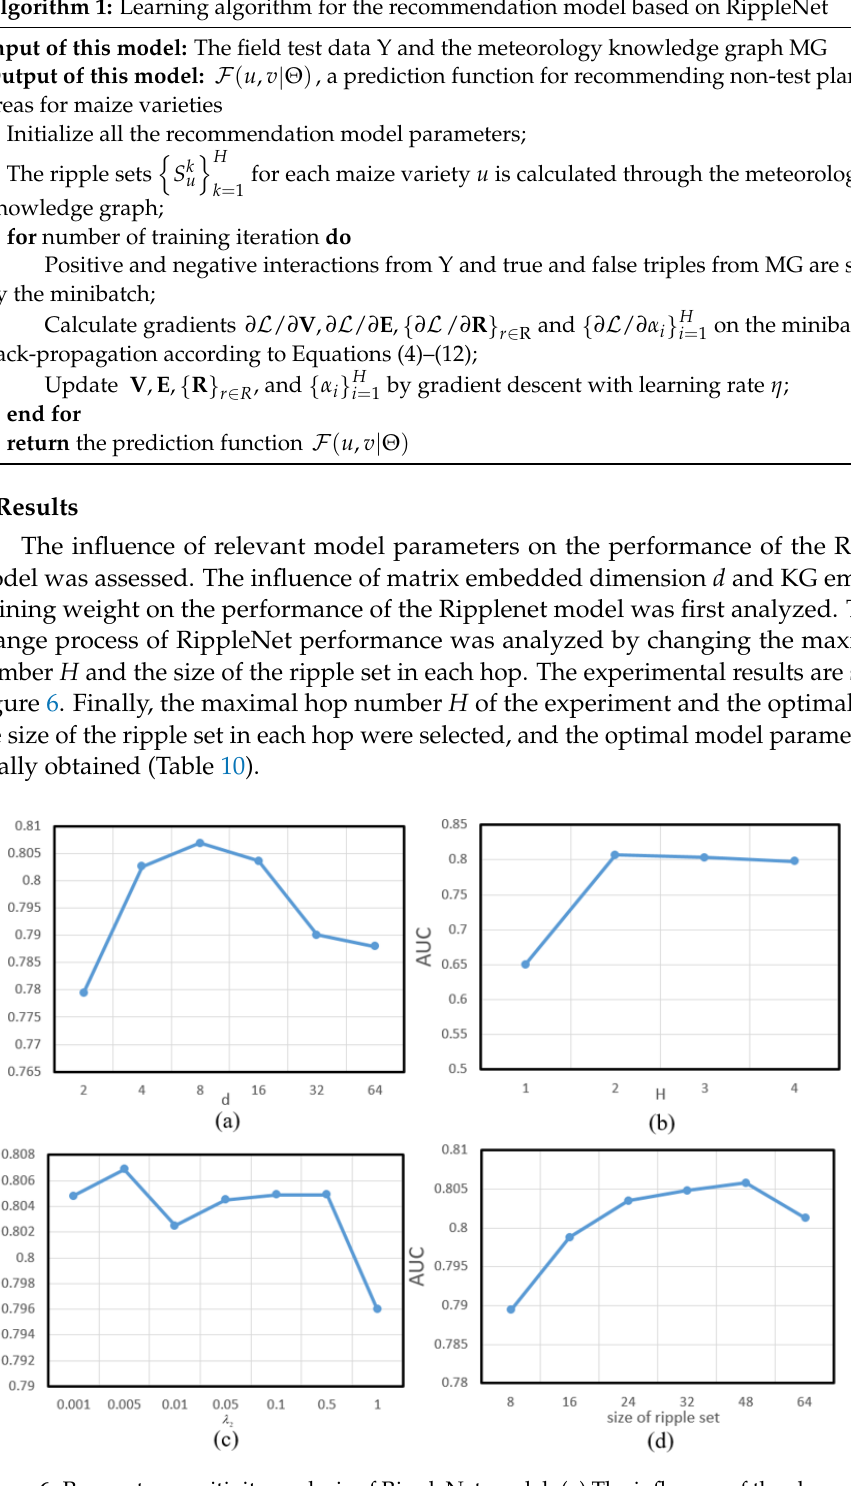
λ on model AUC. 2